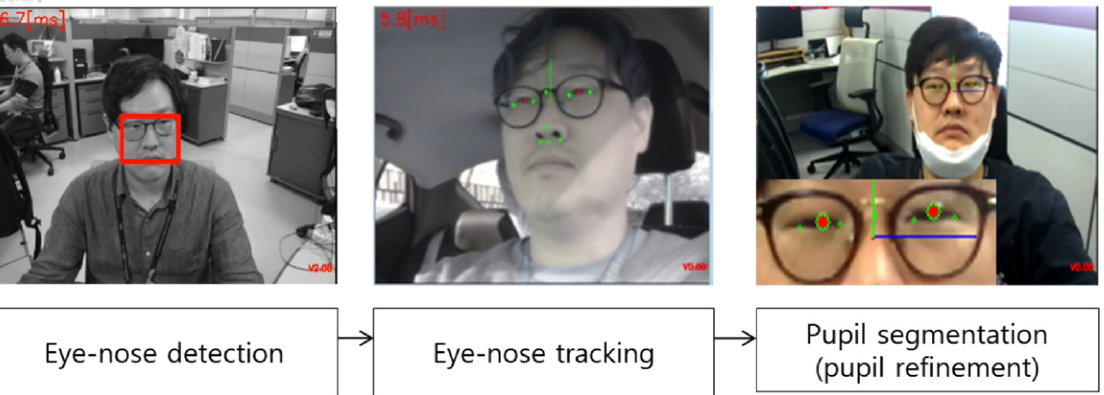
Figure 5. Illustration of the proposed eye tracking method, which includes pupil segmentation modules. The left image shows an extracted subregion (red box) including the eyes and nose of the subject. The middle image shows the 11 landmark points (green dots) used to inform the Supervised Descent Method (SDM)-based shape alignments. In the right image, the green circles around the red points on the eyes indicate the pupil segmentation modules, which increase the accuracy of the eye tracking.